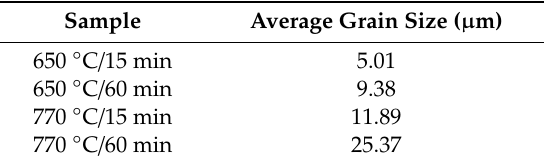
Table 1. The average grain size of Cu-2.7Be alloy at di ff erent annealing temperature and time calculated through Figure